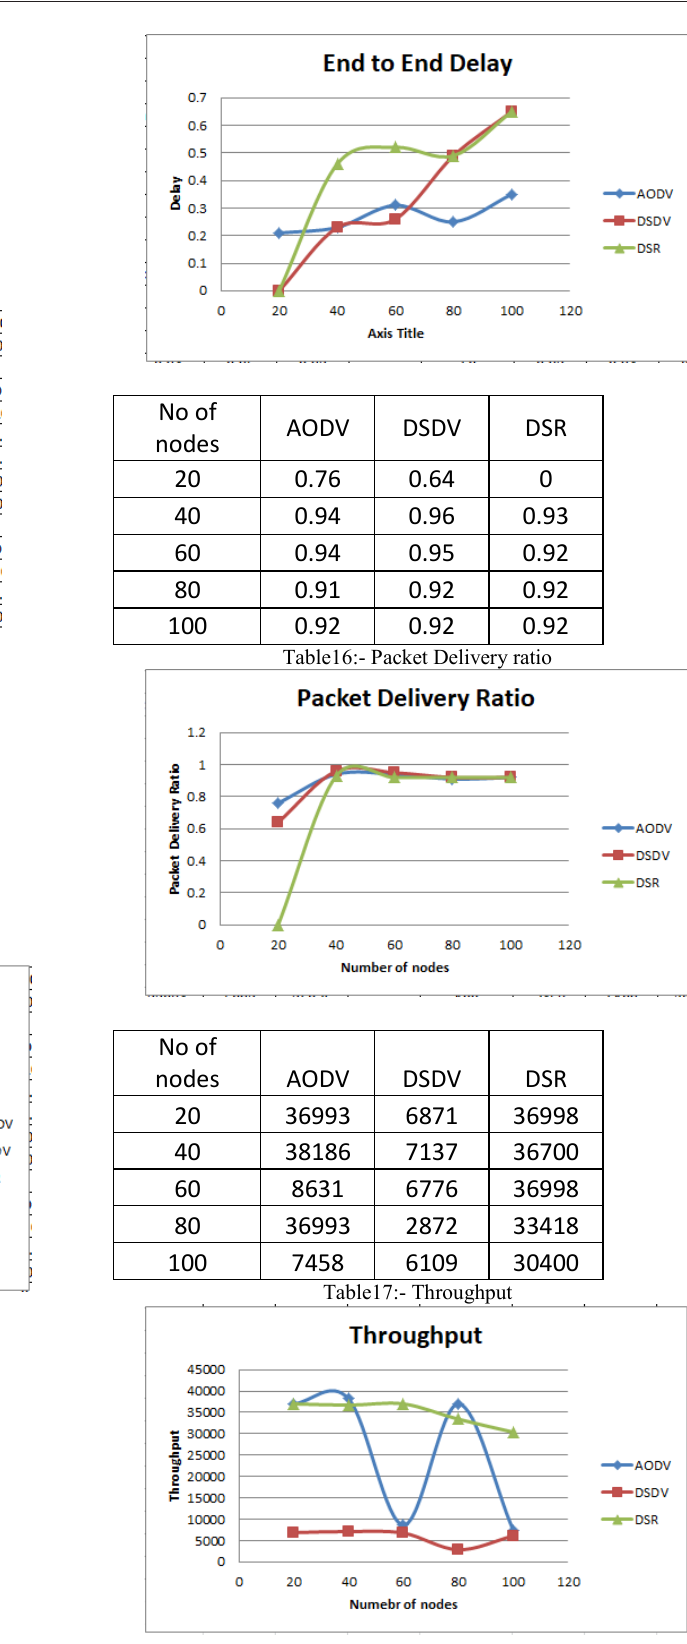
Table 13:- Packet loss